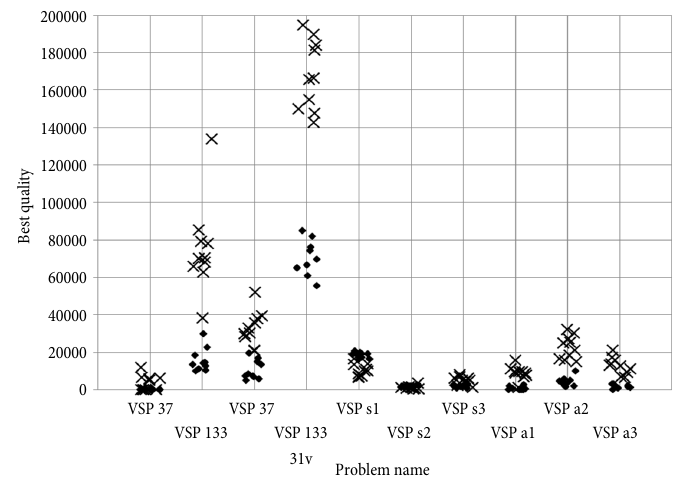
Fig. 5. Quality of best solutions found with